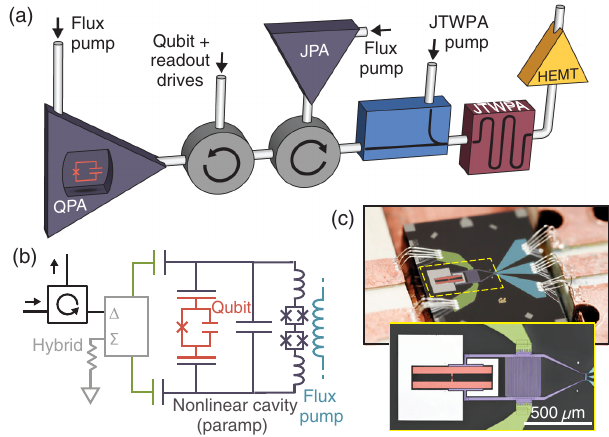
FIG. 1. (a) Simplified experimental setup. The QPA consists of a transmon qubit dispersively coupled to a JPA acting as the readout resonator. A coherent measurement tone reflects off the QPA, carrying qubit-state information to a second, off-chip JPA followed by a JTWPA. (b),(c) Schematic and false-colored images of the QPA. The port at right (cyan) flux couples a pump tone to the JPA, producing on-chip